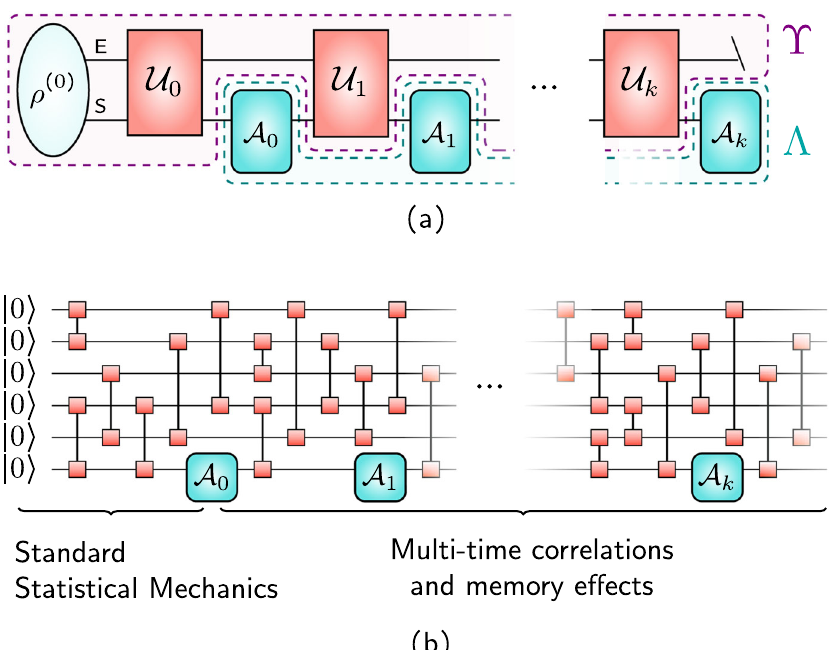
Fig. 1 Quantum processes and the process tensor. a A k -step quantum process ϒ on system S alone is due to the time evolution of an initial system- environment ( SE ) state ρ (0) with distinct unitary transformations U i with i = 0, 1, … , k . In between each pair of unitaries, an external operation (e.g., a measurement) A i for i = 0, 1, … , k is applied; this can also be described by a tensor Λ . b An n -qubit SE -system ( 0 j i depicting a single qubit) with two-qubit gate interactions (depicted by vertical lines between squares) only: a subsystem qubit is probed at the i th step through A i . While the standard approach towards typicality or equilibrium properties concerns the whole SE dynamics and/or a single measurement on system S as in Standard Statistical Mechanics, we show that complex — not necessarily uniformly random — dynamics within large environments will be highly Markovian with high